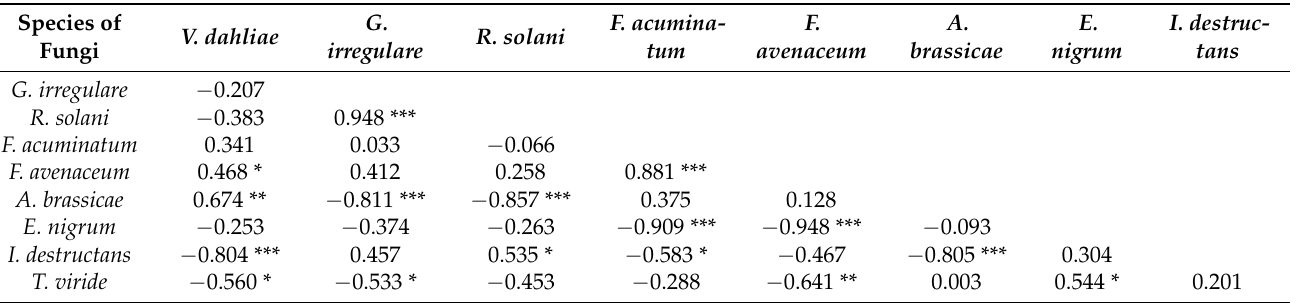
Table 6. Correlations between microorganisms occurring with the highest frequency in the communities of microorganisms isolated from diseased horseradish roots.